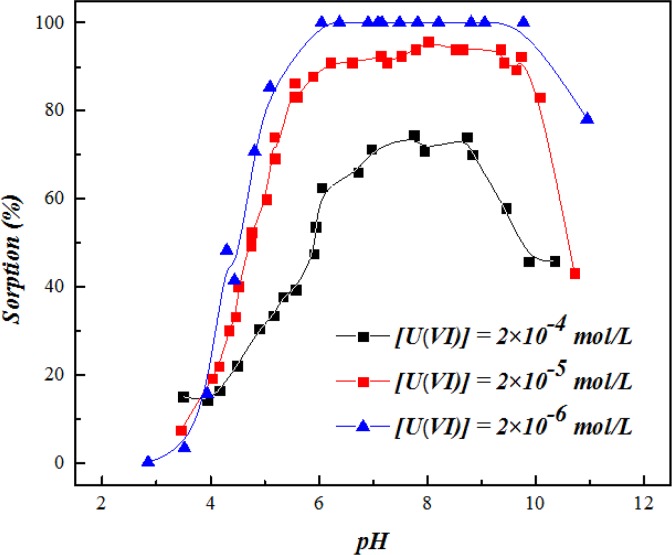
The influence of pH on U(VI) sorption on SONPs under varying uranium concentrations (T = 298±1 K, I = 0.01 mol/L NaClO4, s/l = 0.6 g/L).